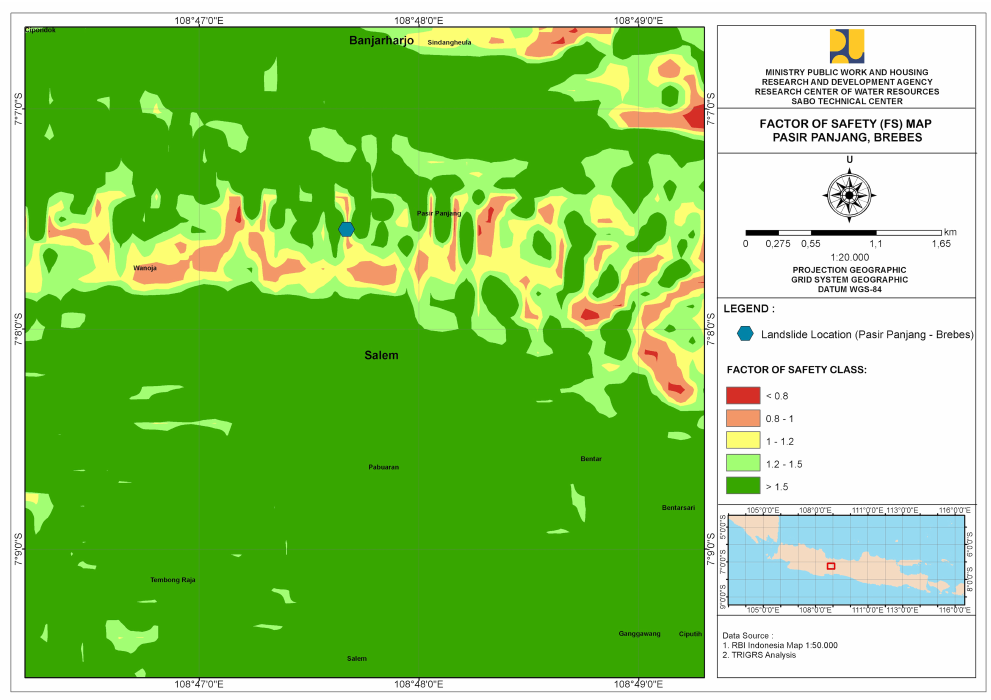
Figure 10. A factor of safety map for Brebes region simulated using the Transient Rainfall Infiltration and Grid-based Regional Slope-stability (TRIGRS) model on 20 February